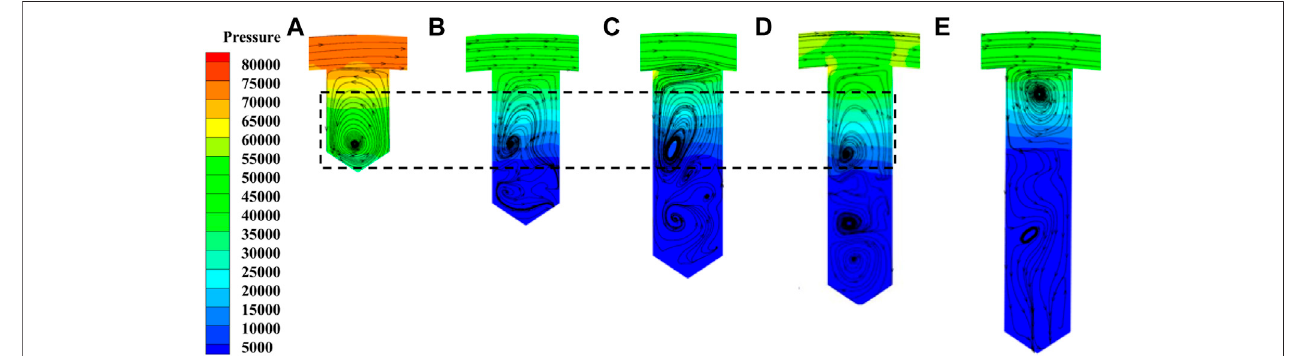
FIGURE 9 | Streamline distribution in hole of different hole height: (A) H 1 = 25 mm, (B) H 2 = 35 mm, (C) H 3 = 45 mm, (D) H 4 = 55 mm, and (E) H 5 = 65 mm.